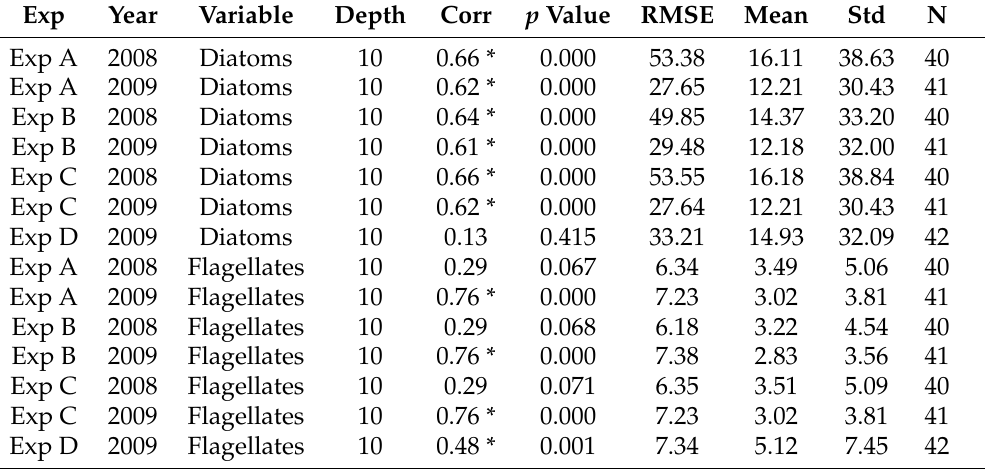
Table A2. Pearson correlations for experiments A–D, between observed and modeled variables for 2008–2009 at the shallowest depth available. Significant correlations at the 95% are indicated by *.